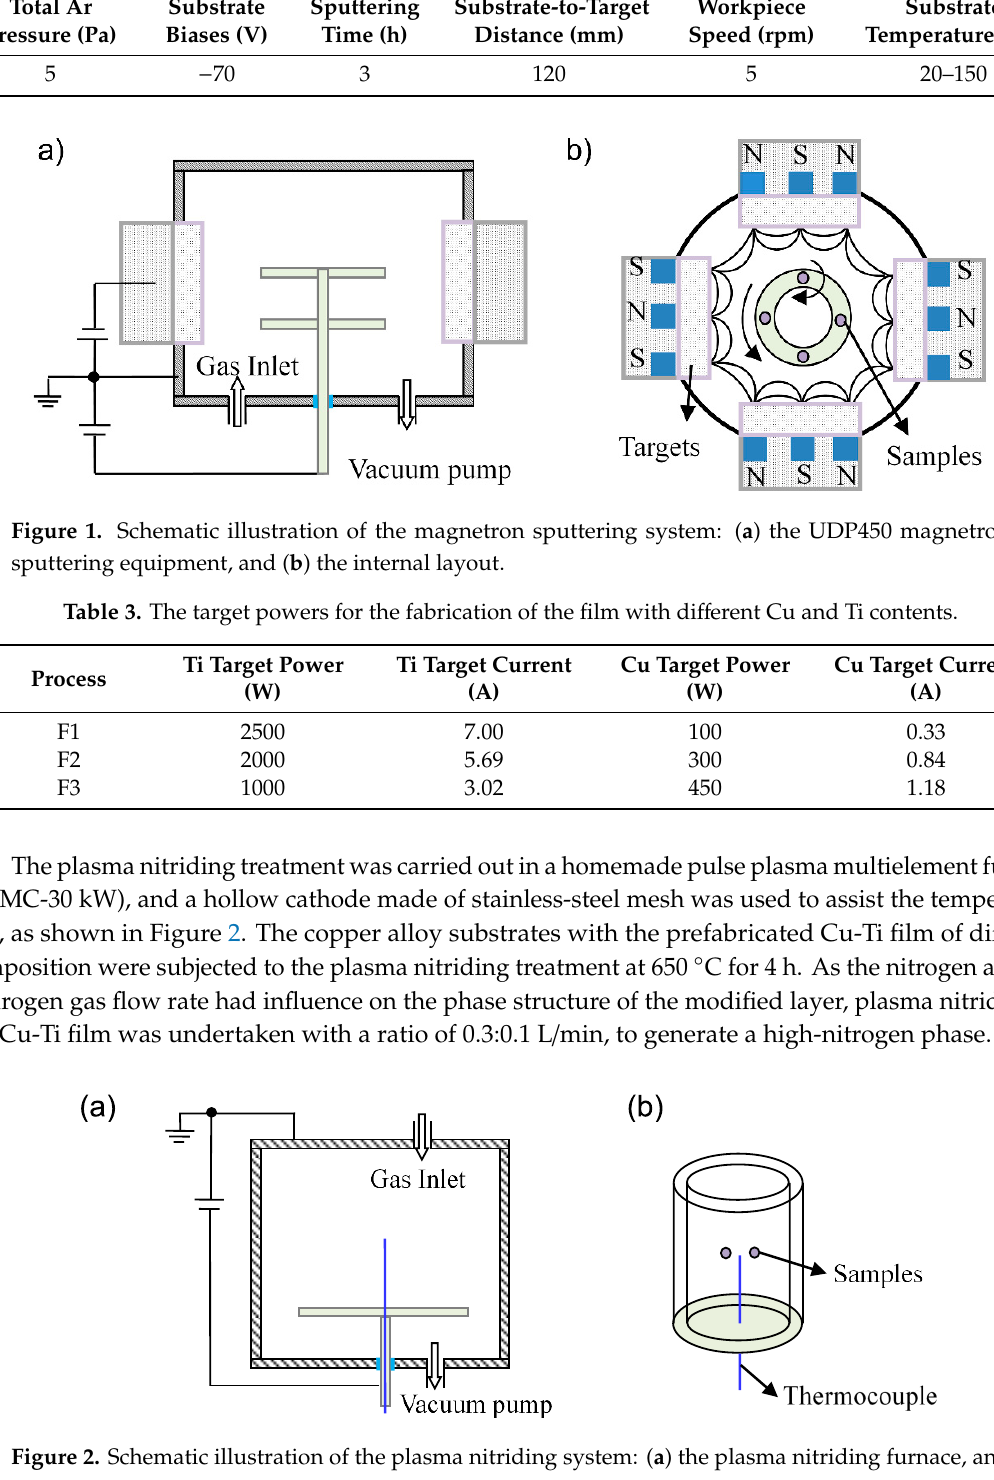
Figure 2. Schematic illustration of the plasma nitriding system: ( a ) the plasma nitriding furnace, and ( b ) the hollow cathode equipment.